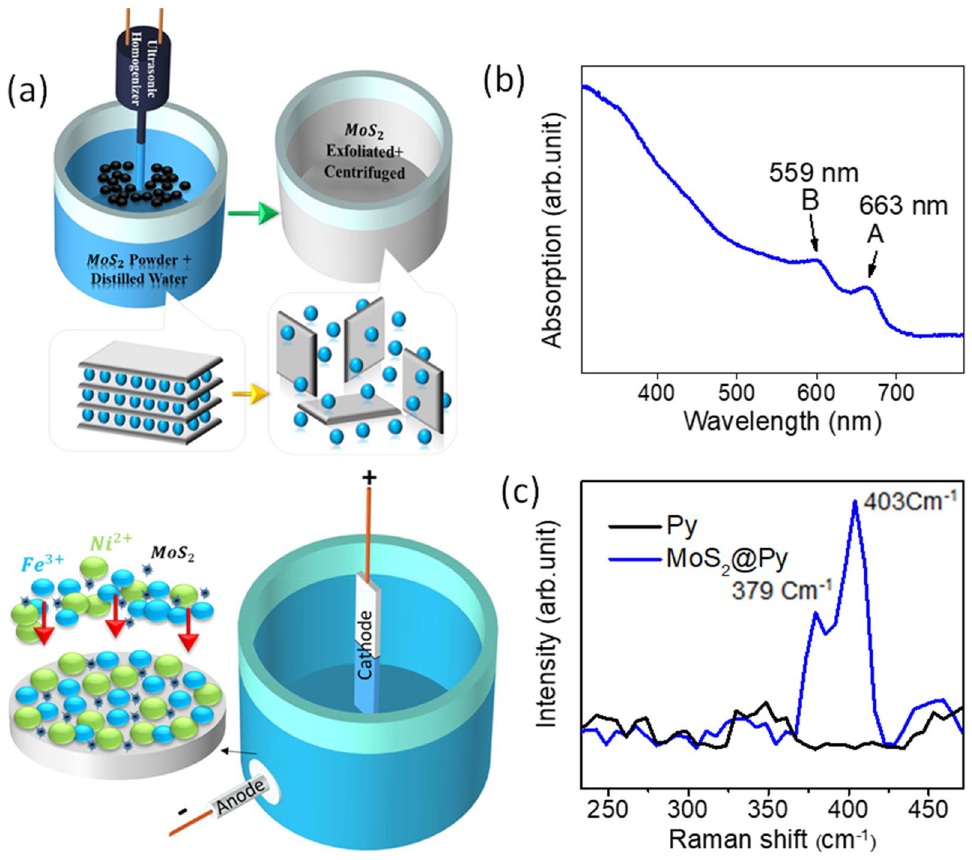
Figure 1. ( a ) Schematic of the MoS 2 exfoliation by probe sonication (above) and the schematic of electrodeposition of samples (below). ( b ) The UV–Visible absorption of the exfoliated MoS 2 and ( c ) the Raman spectrum of Py and MoS 2 @Py